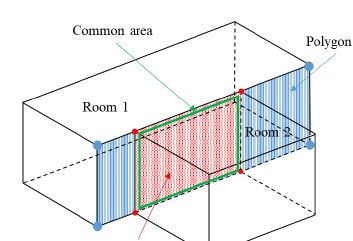
Figure 3. Case 2: Both rooms share an edge and a portion of the area of the neighbouring wall. 3. Two adjacent rooms share a portion of the division wall. This portion corresponds with the polygon of the smallest room and is totally contained into the polygon of the biggest one (Figure 4).